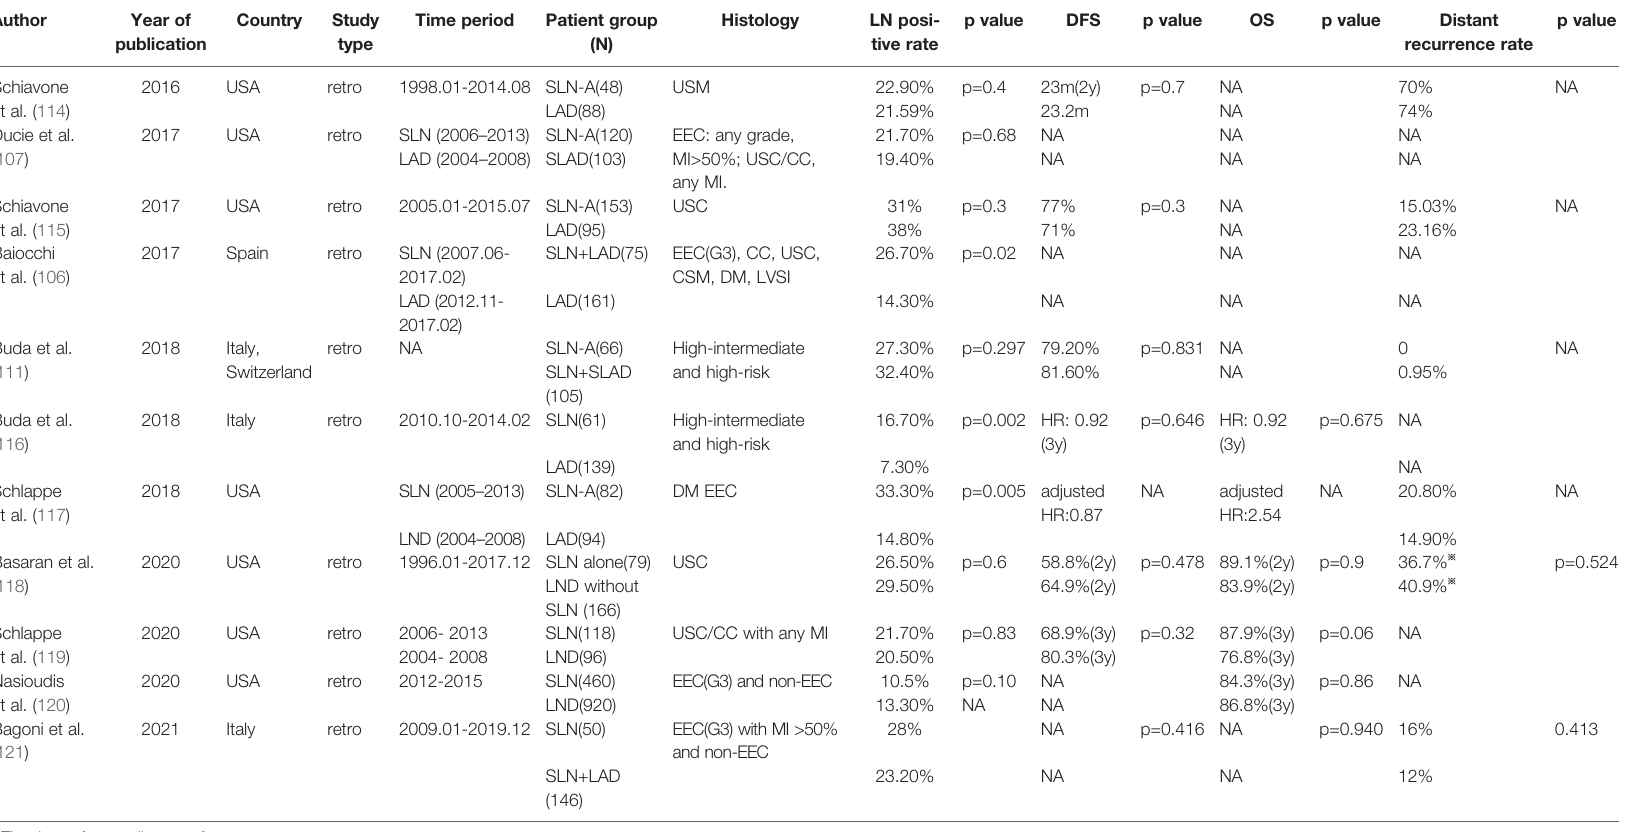
TABLE 2 | The oncologic outcomes of SLNM in high-risk